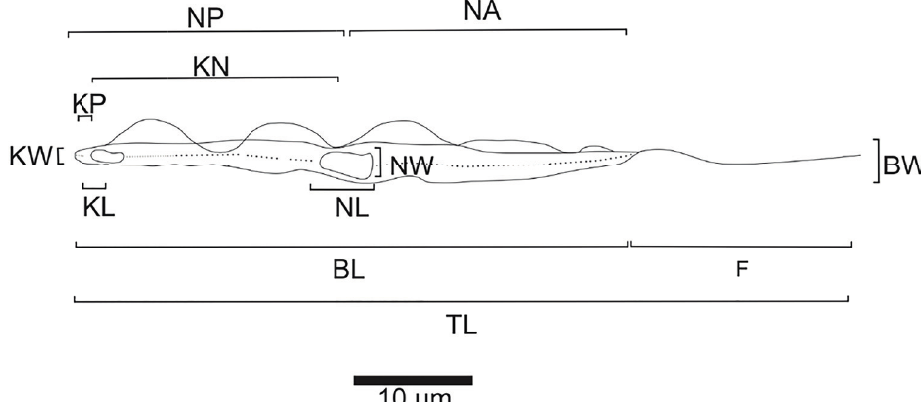
Figure 3. Measurements of Trypanosoma spp. in Pterygoplichthys pardalis from the Tapajós River, in eastern Amazon (Brazil). Total body length with fl agellum (TL), body length along the midline (BL), body width at the center of the nucleus (BW), free fl agellum length (F), nucleus length (NL), nucleus width in the central portion (NW), distance from the center of the nucleus to the anterior extremity (NA), distance from the center of the nucleus to the posterior extremity (NP), distance from the center of the kinetoplast to the center of the nucleus (KN) , kinetoplast length (KL), kinetoplast width (KW) and distance from the center of the kinetoplast to the posterior end